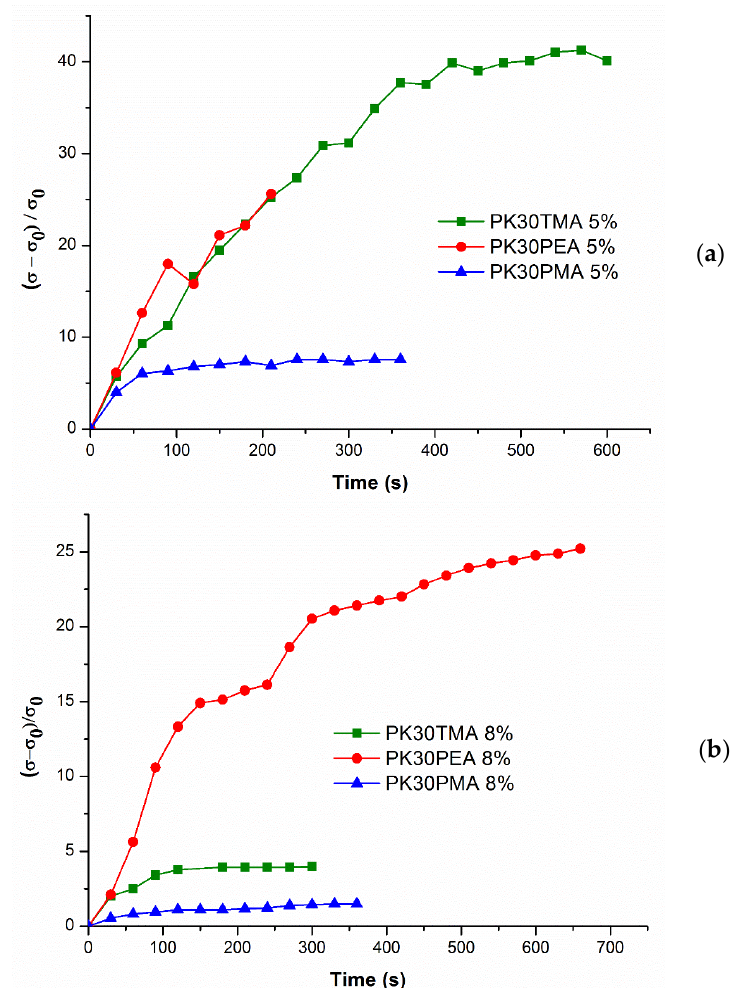
Figure 6. Comparison of the relative conductivity variation of PK30TMA, PK30PEA, and PK30PMA nanocomposites containing the ( a ) 5 wt % and ( b ) 8 wt % of MWCNTs as a function of the annealing time at 75 °C.